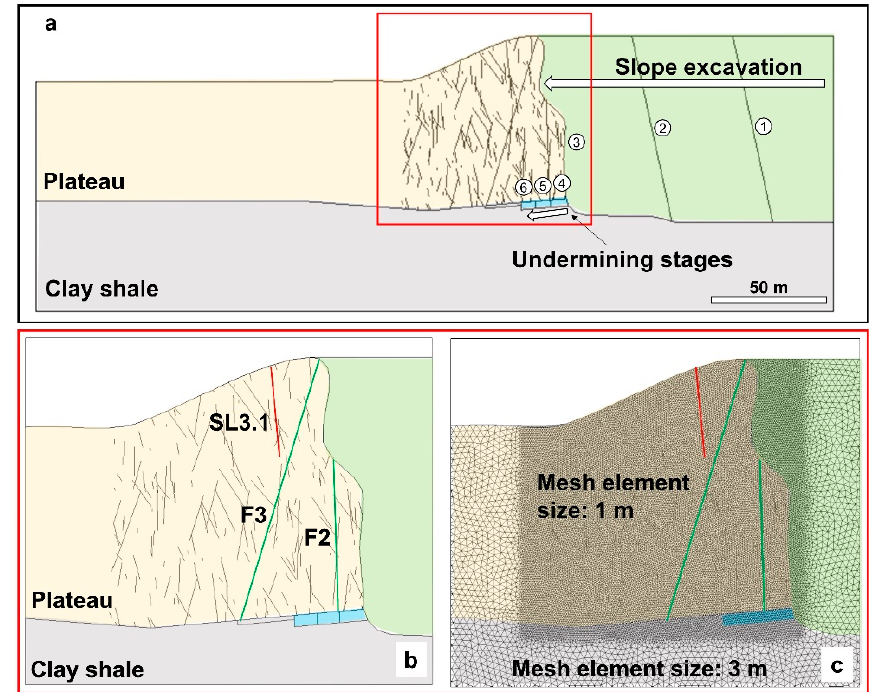
Figure 9. Two-dimensional geometry investigated in Elfen. ( a ) Overview of the modelled excavation and undermining of the plateau. Numbers in the circles show the progressive excavation and undermining stages; ( b ) Detail of the DFN and first-order geological structures; ( c ) Meshed model. Note that F2 and F3 are omitted from Model 1 and included in Model 2.